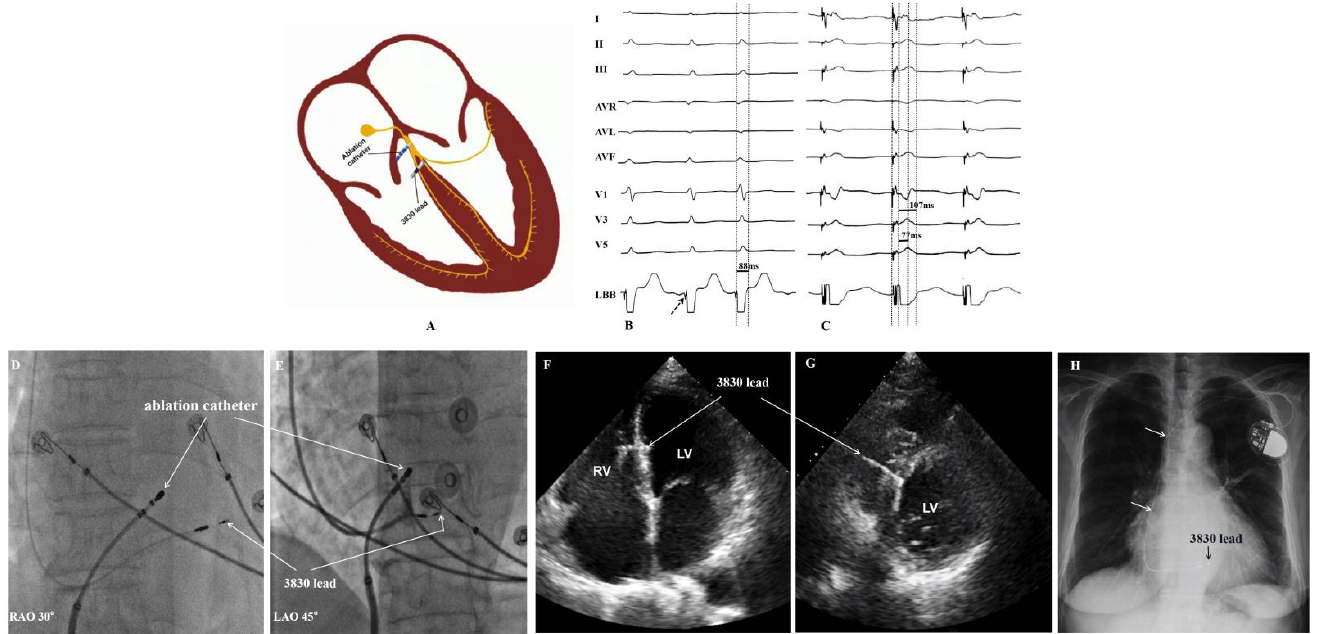
Figure 1. Left bundle branch area pacing. ( A ): Diagram of the LBBaP and AVNA. ( B ): LBB potential recorded from the 3830 lead (dash arrow). Baseline QRSd of 88 ms. ( C ): The 3830 lead implanted in LBB area successfully; unipolar LBBaP pacing at pacing at 1 V/0.4 ms resulted in LBB capture with QRSd of 107 ms and Stim-LVAT of 77 ms. ( D , E ): Fluoroscopic imaging of LBBaP lead implantation (( D ): RAO 30-deegree fluoroscopic views and ( E ): LAO 45-degree fluoroscopic view). ( F , G ): Echo images demonstrating the location of the LBBaP lead in the interventricular septum (( F ): apical 4-chamber view and ( G ): left parasternal short axis transection view). ( H ): Radiograph of chest after LBBaP and AVN ablation (posteroanterior view). LBB = left bundle branch, LBBaP = left bundle branch area pacing, AVNA = atrioventricular node ablation, RAO = right anterior oblique, LAO = left anterior oblique, RV = right ventricle, LV = left ventricle, Stim-LVAT = pacing stimulus to left ventricular activation time, Echo = echocardiography.